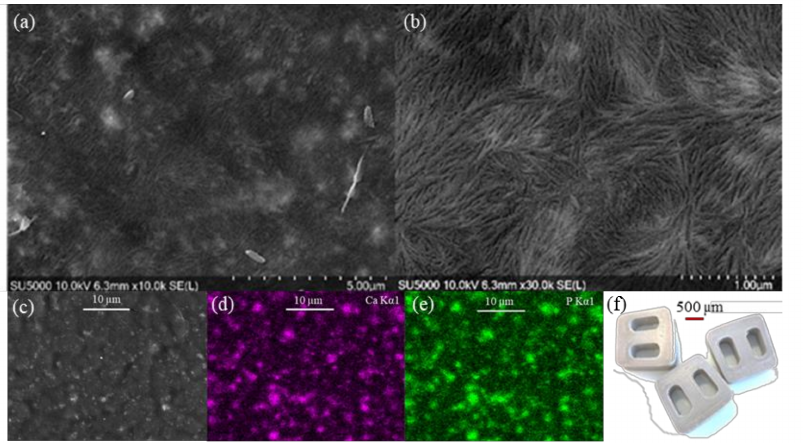
Figure 5. SEM of top 3DP surface for 30 wt% PEEK/HA composite at ( a ) × 10 k and ( b ) × 30 k magnifications. SEM images ( c ) and corresponding ( d ) Ca and ( e ) P elemental maps for 20 wt% PEEK/HA sample, ( f ) photograph of 3DP spinal fusion implants with 20 wt%